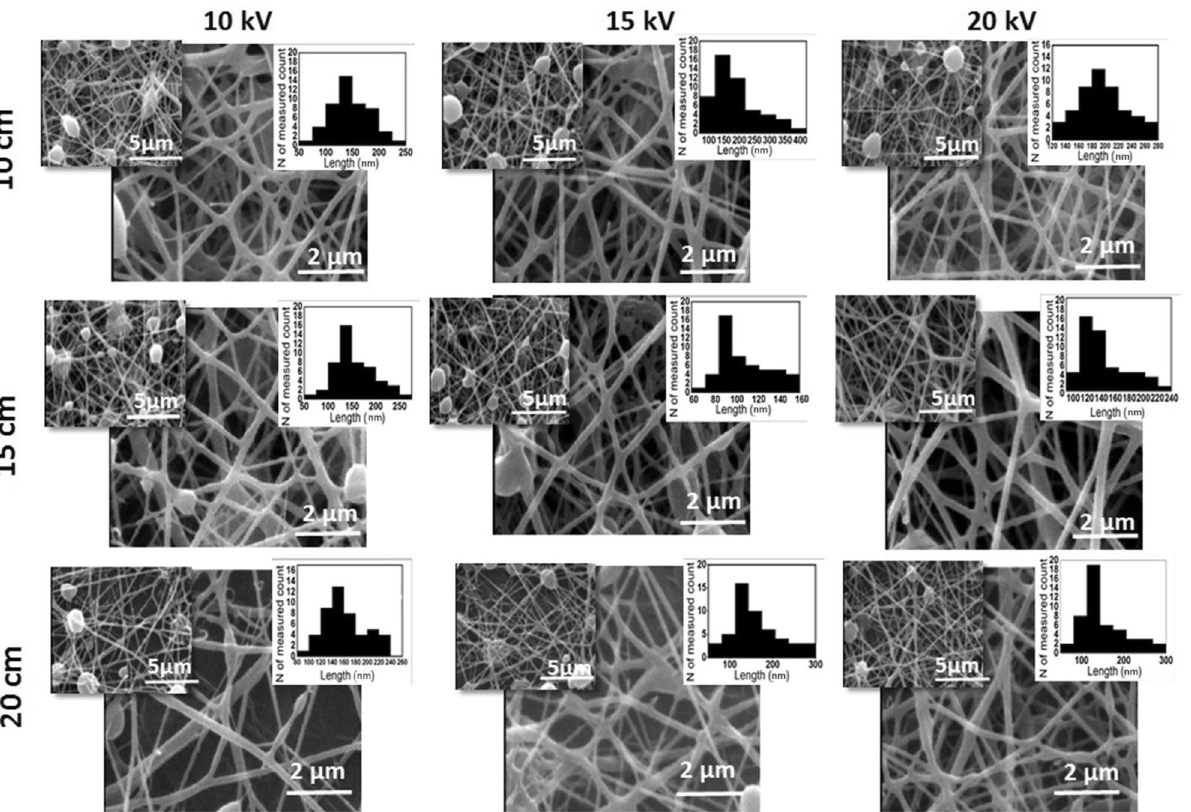
Figure 1. SEM images of PCL-PEG (mass ratio of 1:1) electrospun nanofibers under 10, 15 and 20 kV applied voltage and 10, 15 and 20 cm distance to